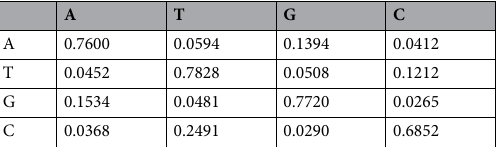
Table 2. The transition probability P matrix describing mutational pressure in the leading DNA strand from Escherichia coli genome. A nucleotide from the column is replaced by a nucleotide from the row.